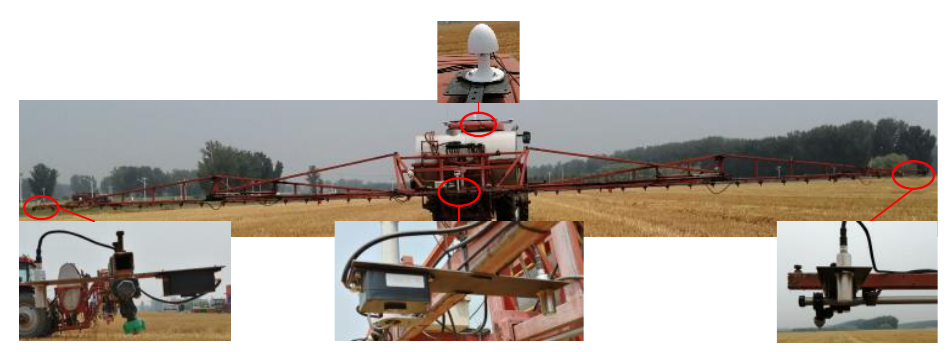
Figure 4. Knapsack boom sprayer.